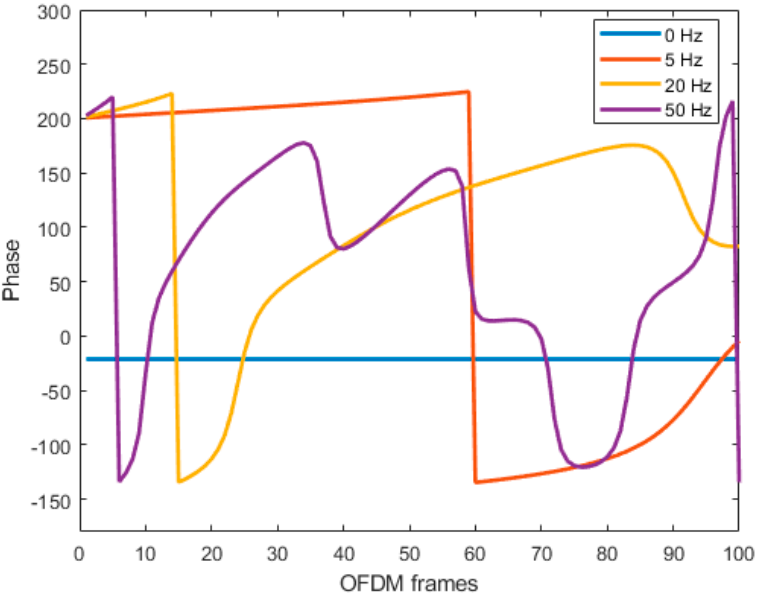
Figure 10. Doppler shift-based phase response.